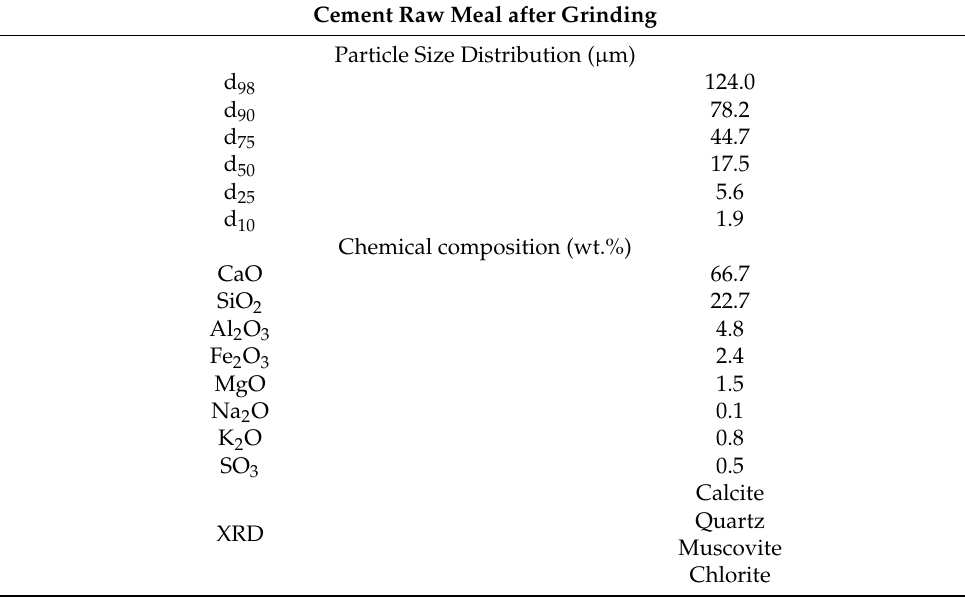
Table 2. Properties of the cement raw meal used in the sandwich coating